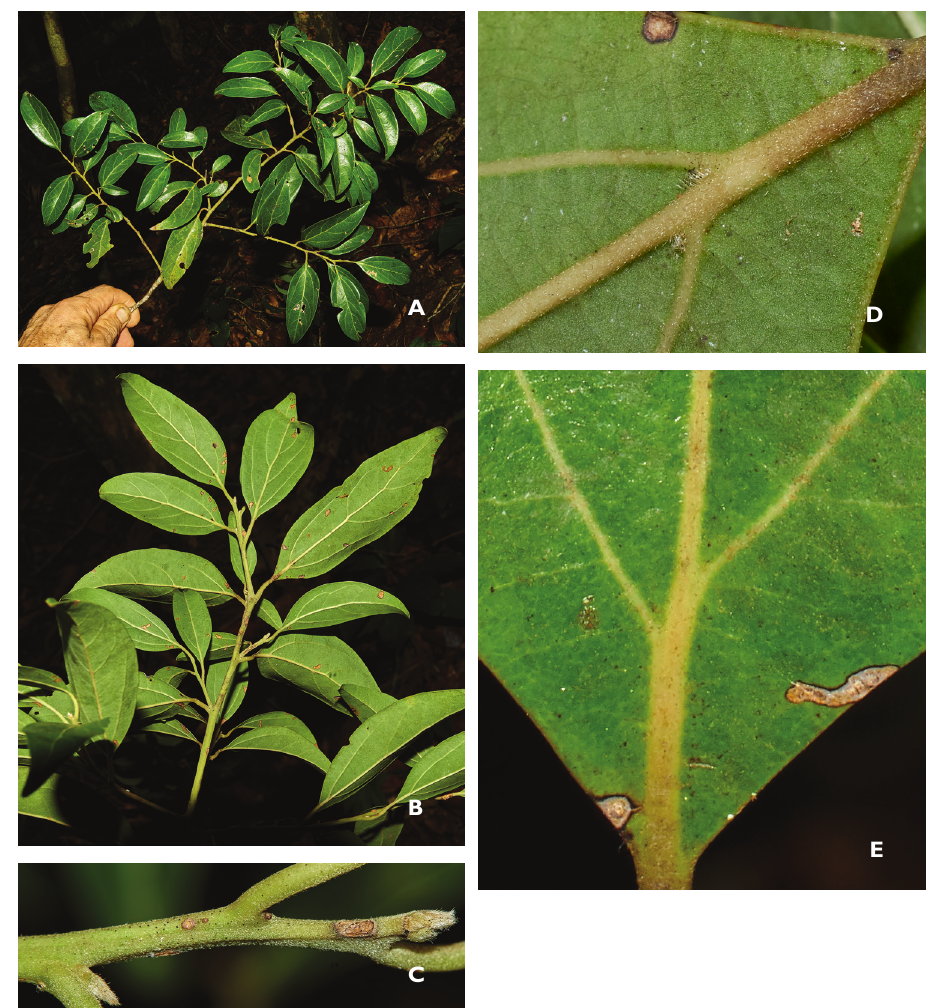
Figure 3. Diagnostic vegetative characters of Cinnamomum bladenense A Branch showing adaxial sur- face and variation of leaf sizes within branches B Abaxial surface of leaves showing matte green laminae and prominent midvein and secondary venation C Young twigs moderately and minutely sericeous with whitish buds D, E From the base of the same leaf lamina, respectively, adaxial surface of secondary vein axils not ampullous, abaxial surface of secondary veins barbellate and plane with the lamina surface. Pho- tos from Brewer & Stott 7529 by SW Brewer 2 February